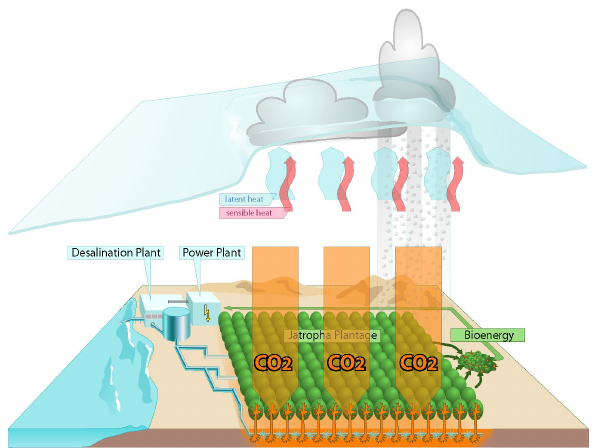
Fig. 2. Scenes from the Jatropha curcas plantation at Luxor, Fig.2 Scenes from the Jatropha curcas plantation at Luxor, Egypt. Upper left: February 2007, upper right: May 2008, bottom left: May 2009, 7 bottom right: May 2010. 8